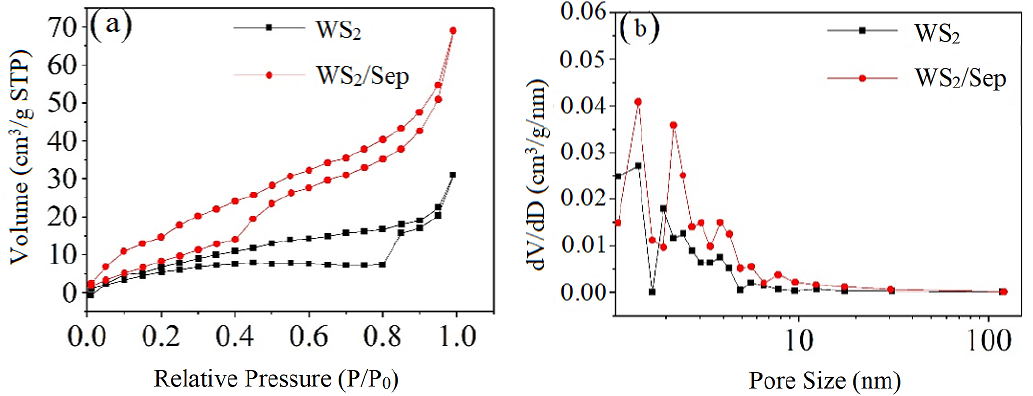
Figure 4. Nitrogen adsorption-desorption isotherms ( a ) and the corresponding pore size distribution curves ( b ) of WS 2 and WS 2 /sepiolite composite.